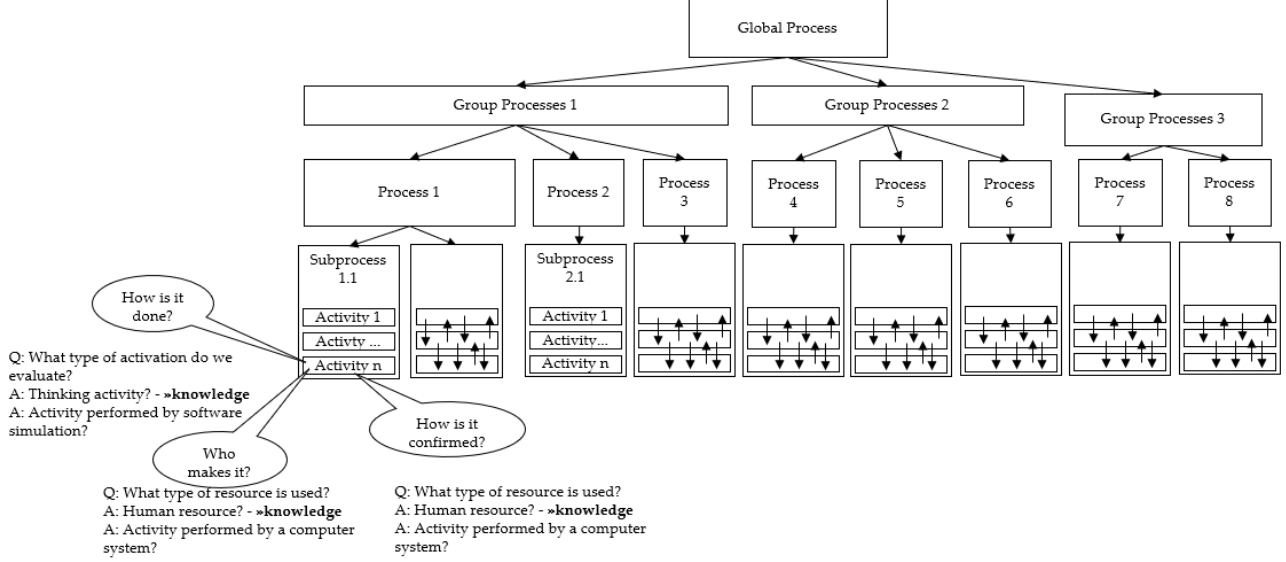
Figure 4. Model designed to detail the global engineering process.